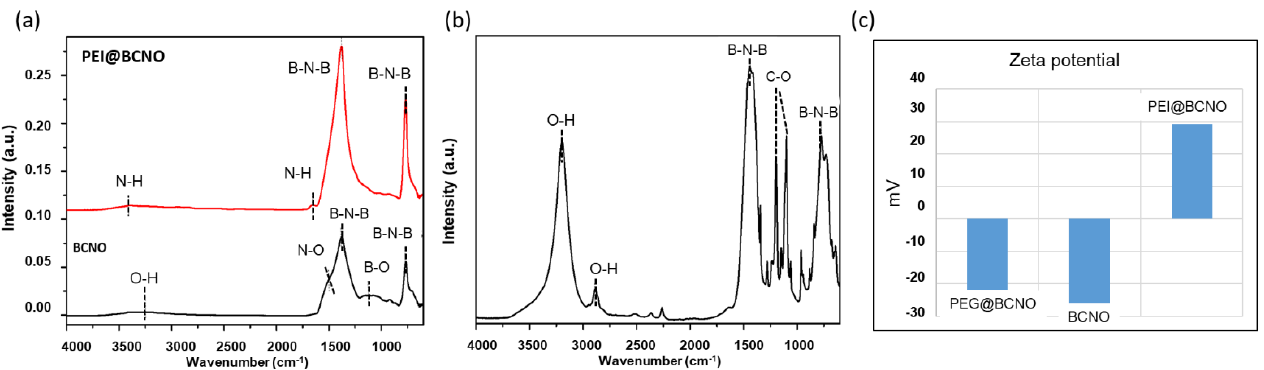
Figure 3. ( a ) FTIR spectrum of bare BCNO and PEI@BCNO ( b ) FTIR spectrum of PEG@BCNO ( c ) Zeta potential measurement of the surface charge of BCNO and polymer functionalized BCNO.